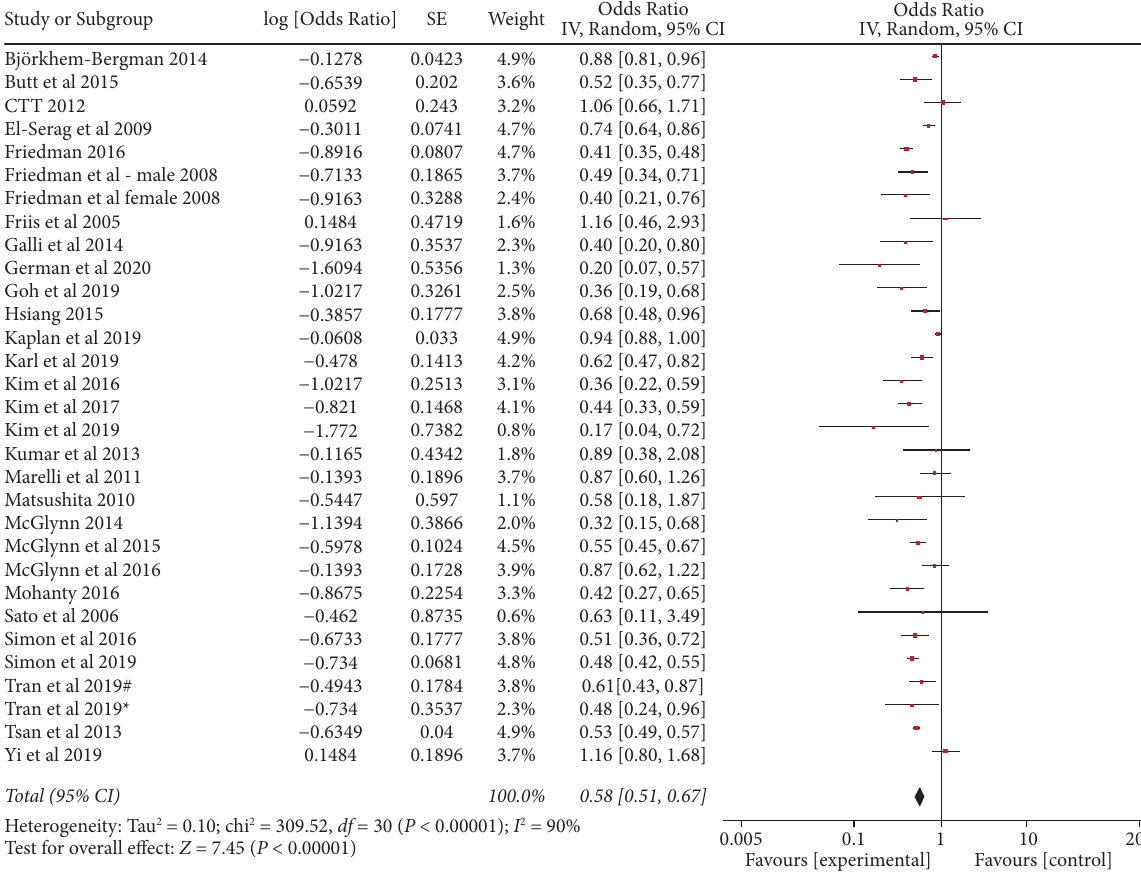
Figure 3: Statin and risk of hepatocellular carcinoma—adjusted